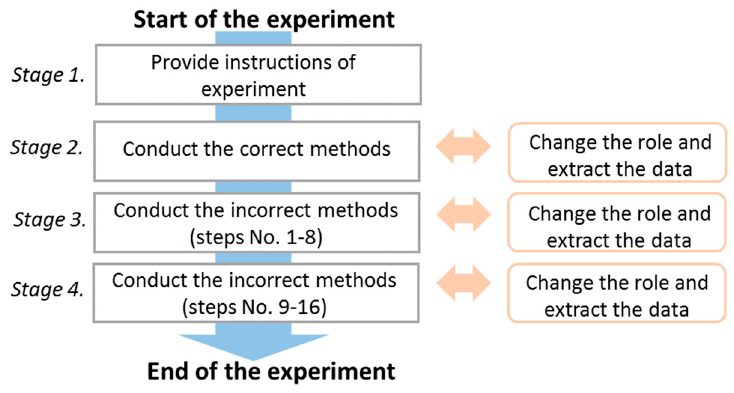
Figure 4. Experimental procedure.